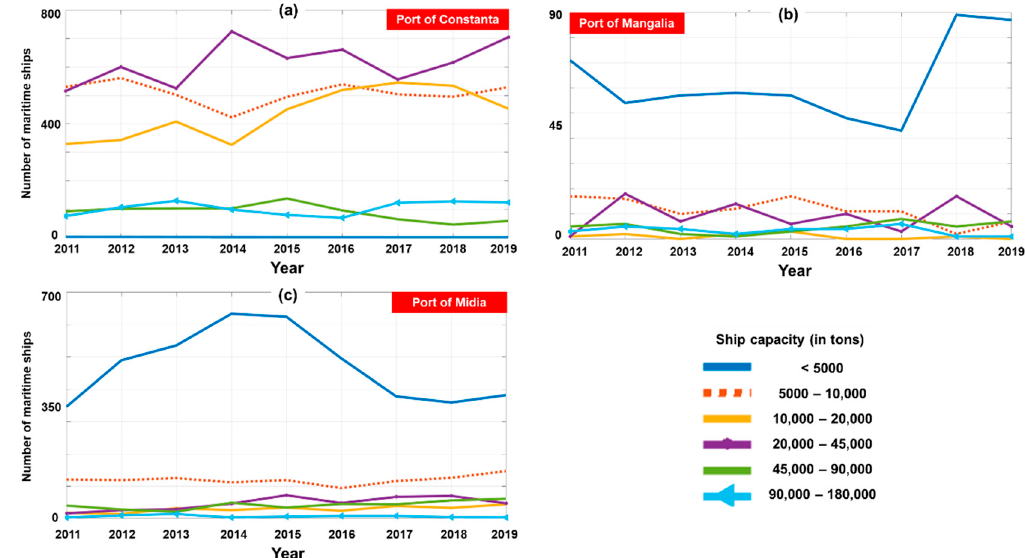
Figure 3. Number of maritime ships reported for the main Romanian ports. The results include different ships capacities, being reported for: ( a ) Port of Constanta; ( b ) Port of Mangalia; ( c ) Port of Midia. Data processed from [21].